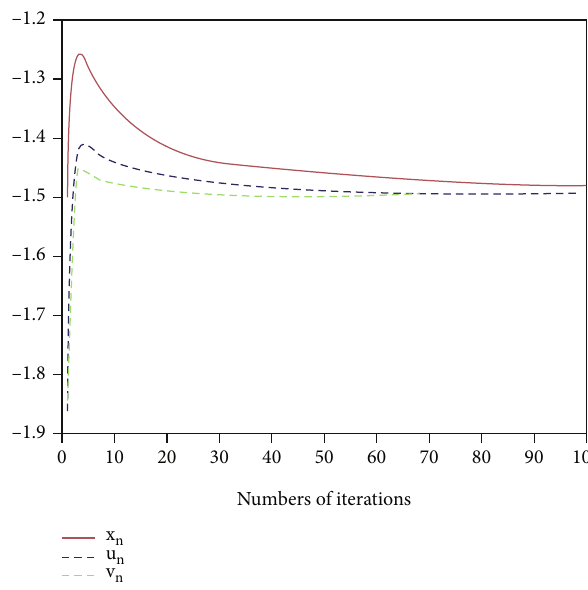
Figure 1: Convergence of iterative sequences f u to z = − 1 : 5 for β